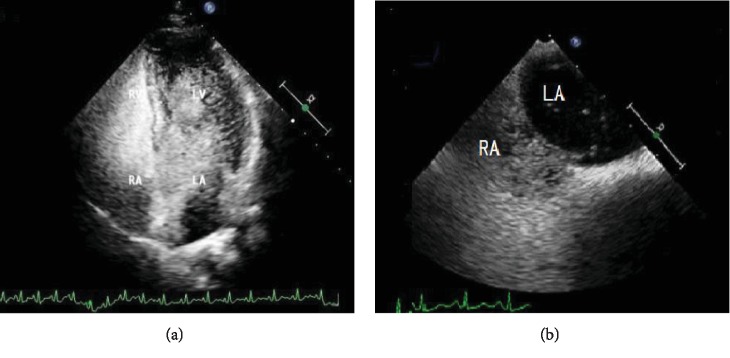
The quantification of the shunt in a patient using two techniques. (a) cTTE shows the left ventricle nearly filled with microbubbles after opacification of the right chambers within the first 3 circles in every single frame image. (b) cTEE shows ≤10 microbubbles appearing in the left atrium after opacification of the right chambers within the first 3 cardiac cycles in every single frame image.